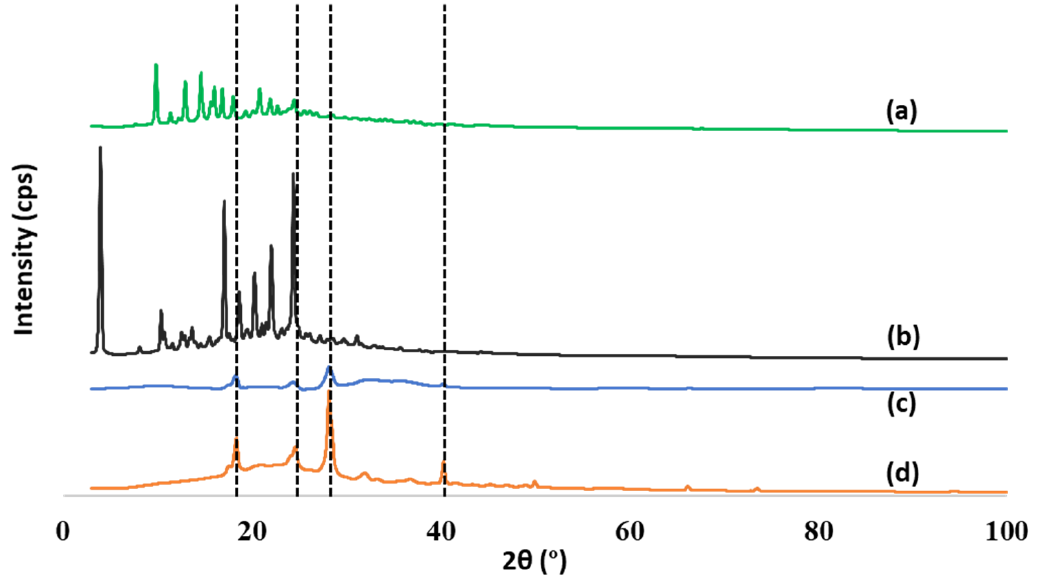
Figure 6. Powder XRD patterns: ( a ) FP, ( b ) SAL, ( c ) (FP-SAL/Lys-PA) NCs and ( d ) Lys-PA.